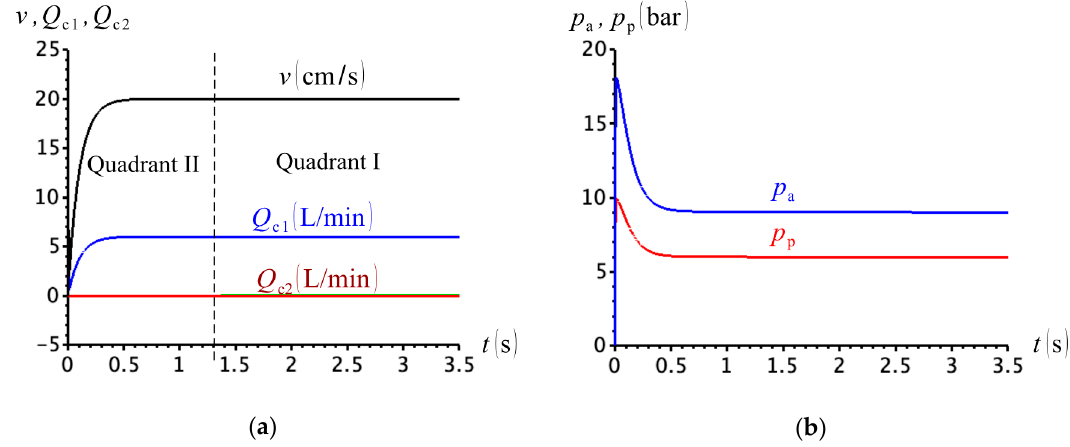
Figure 24. Circuit using a logic valve.